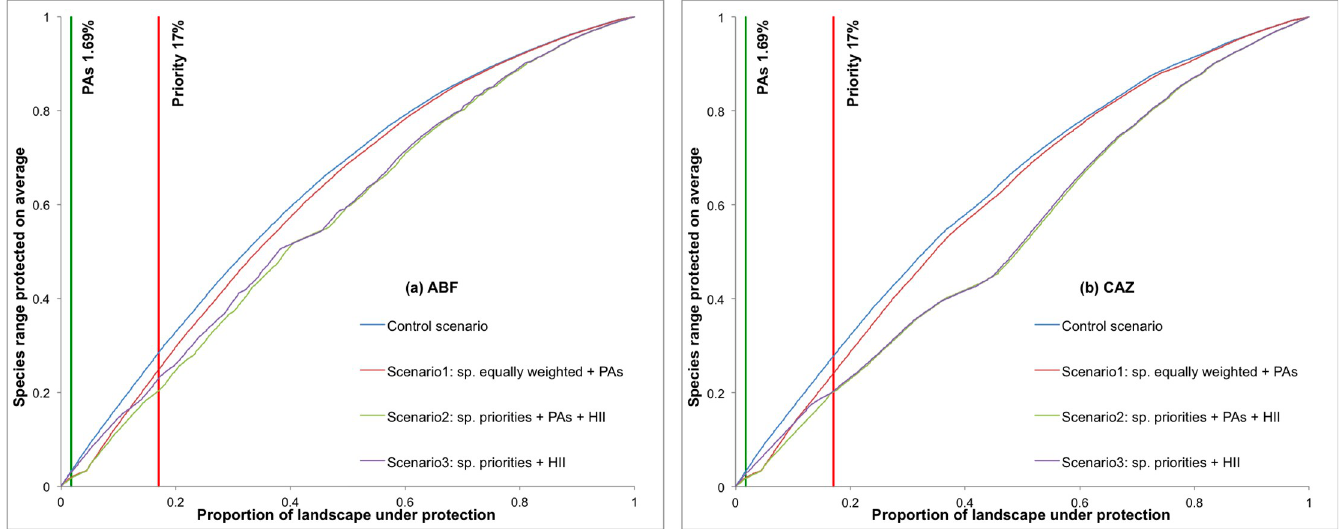
Fig 5. Performance curves of the spatial prioritization solutions for both removal rules ABF [Added Benefit Function] (a) and CAZ [Core Area Zonation] (b). Each line represents a scenario [Control scenario: species equally weighted; Scenario 1: species equally weighted + PAs; Scenario 2: species individual weighted + PAs + cost (Human Footprint-HII) and; Scenario 3: species individual weighted + cost (HII)] showing the proportion of landscape protected and its corresponding average species range protected. The vertical lines represent current proportion of land in PAs (1.69%) and the recommended AICHI target (17%)